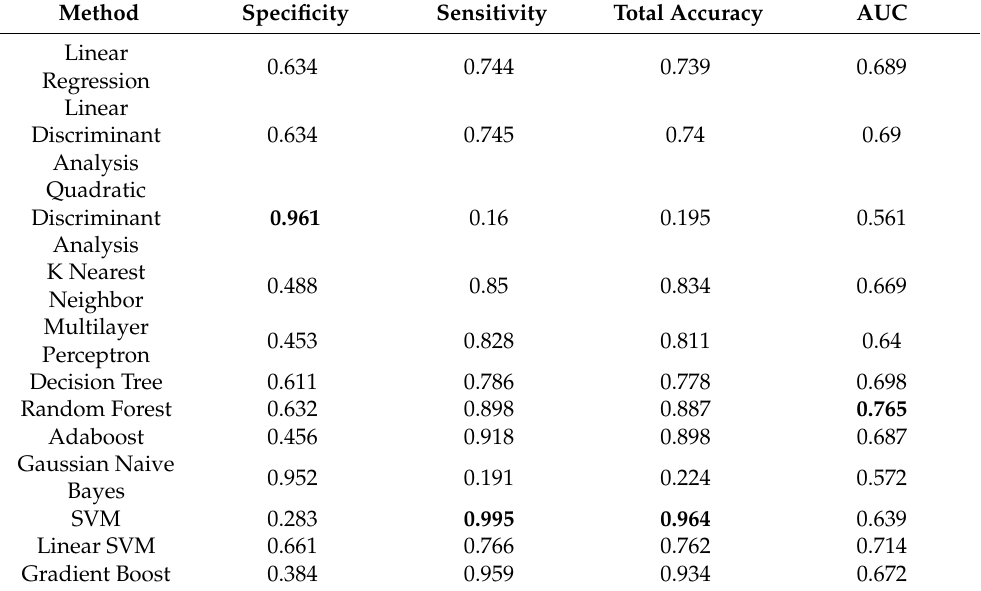
Table 1. Results for standard ML